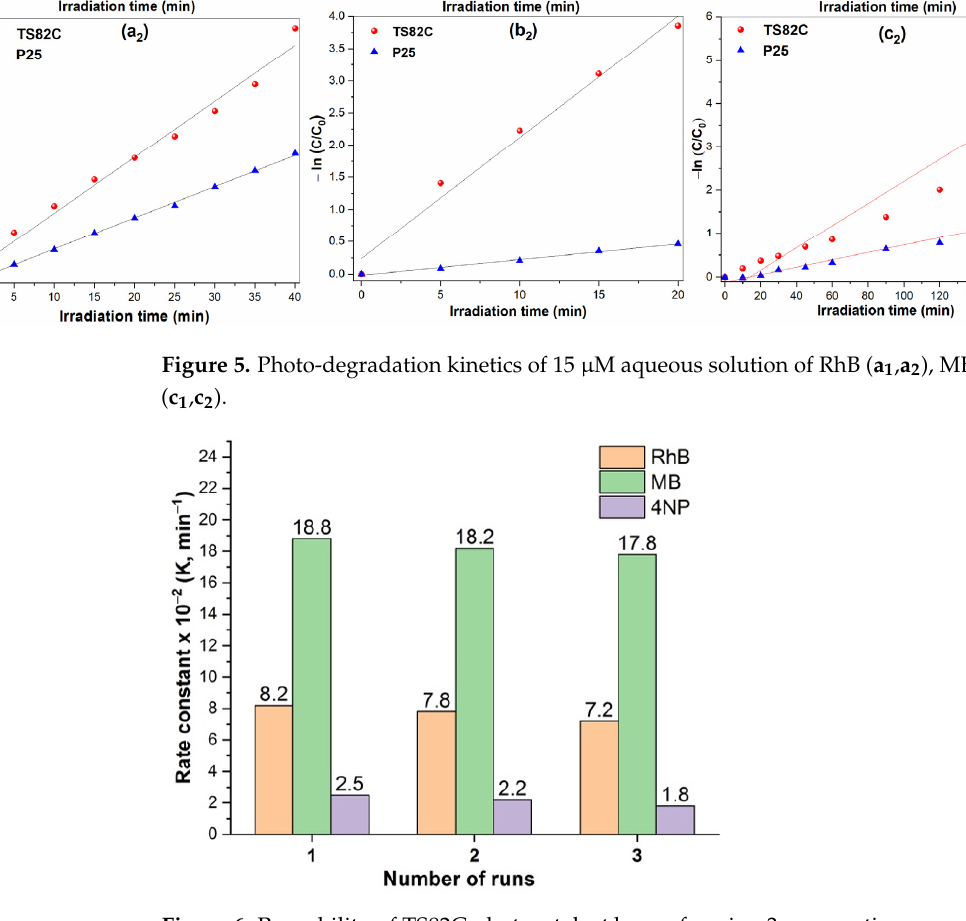
Figure 6. Reusability of TS82C photocatalyst by performing 3 consecutive runs with RhB, MB and 4NP dyes.